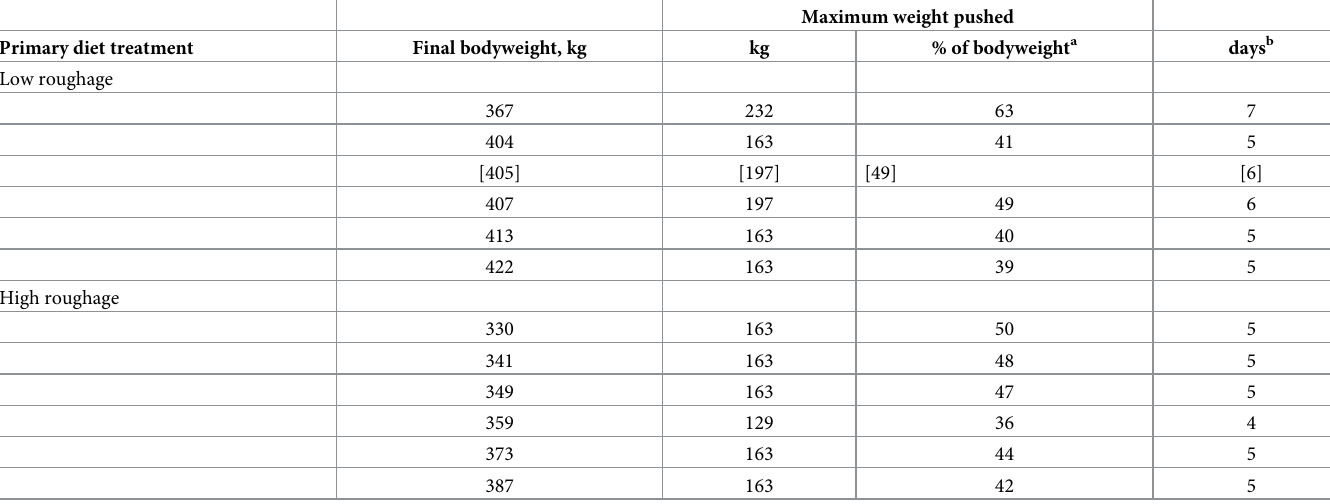
Table 2. Bodyweight and maximum weight of a gate heifers pushed to access